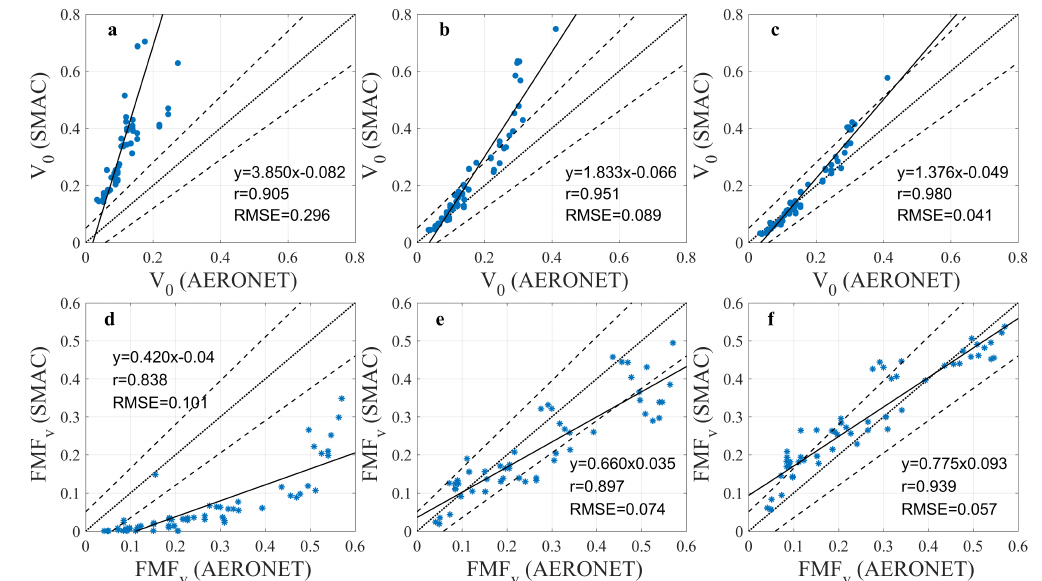
Figure 6. The scatter plot of retrieved V 0 (upper panel) and FMF v (lower panel) compared to the AERONET inversion products. ( a ) and ( d ) denote the scenarios of two channels (490, 670 nm). ( b ) and ( e ) denote the scenarios of four channels (490, 550, 670, and 870 nm). ( c ) and ( f ) denote the scenarios of all the five intensity channels (including 1610 nm), respectively. The solid line, dotted line, and dashed line represent the fit line, 1:1 line, and the expected error line ( ∆ x = ± 0.05 ± 0.15 x ),